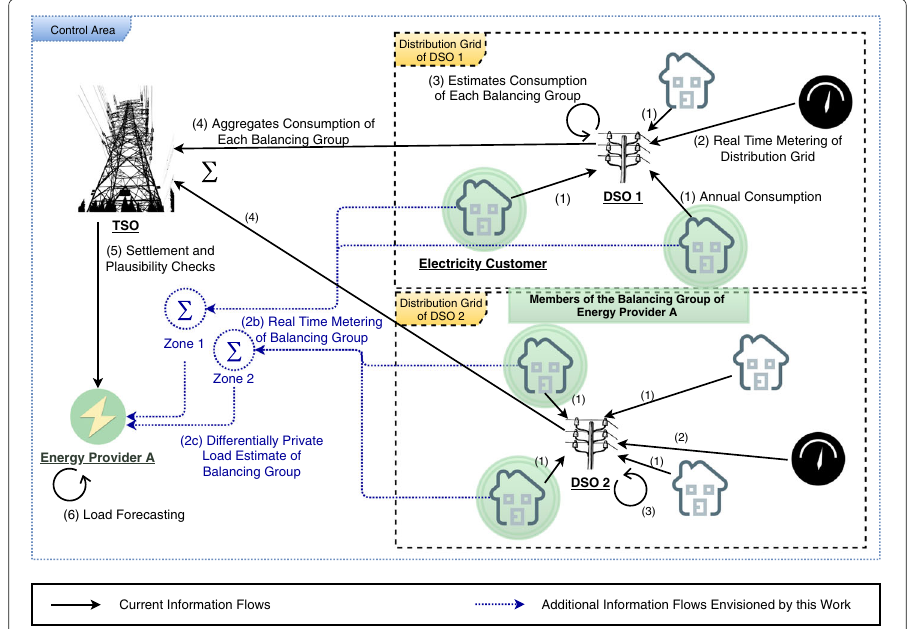
Fig. 1 Essential roles and information flows in the current metering process (solid black arrows) and in the proposed differentially private process for privacy-preserving forecasting (dotted blue arrows). For